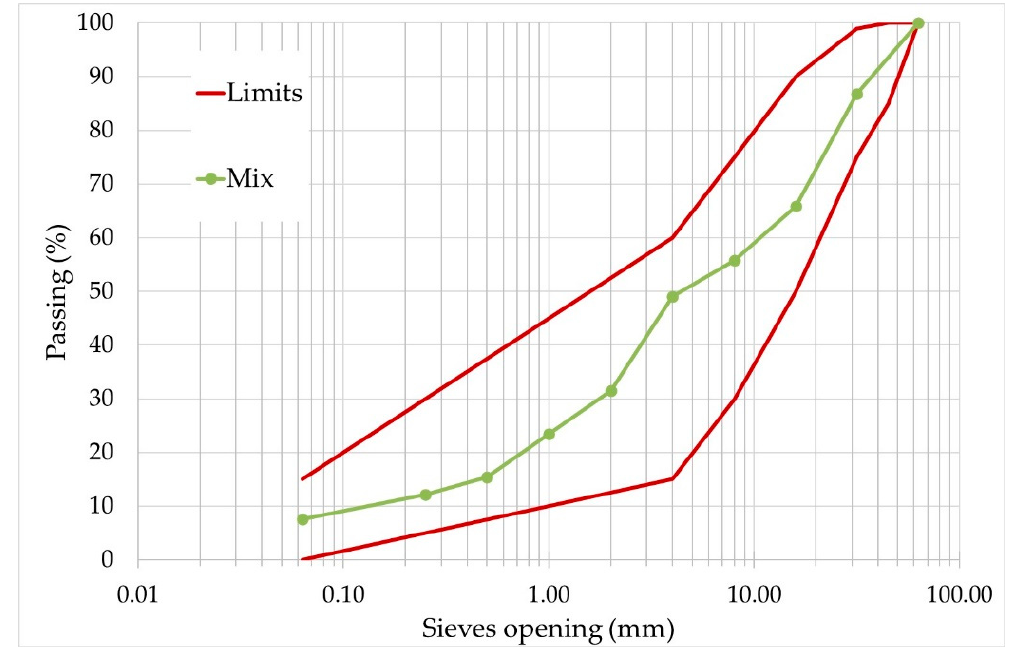
Figure 3. Particle size distribution and grading envelope 0/31.5 GU for road subgrades of CDW.